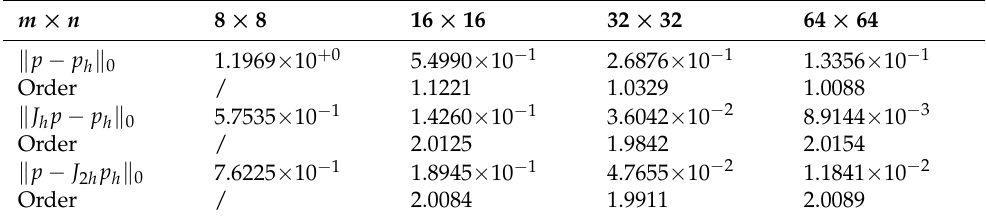
Table 2. The numerical errors and convergence orders at t = 0.1 of p .